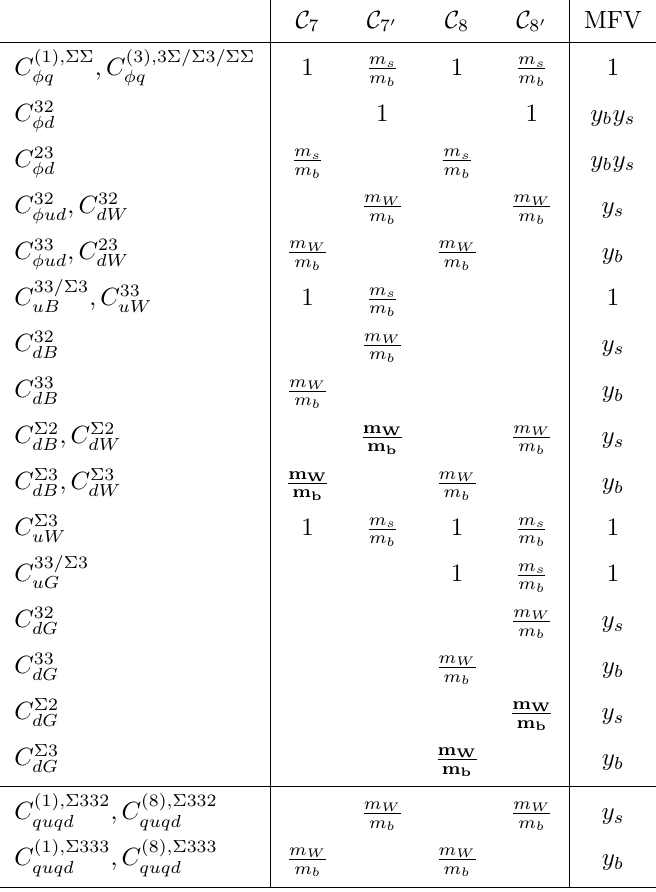
Table 10 . Scaling of SMEFT coefficients with the external quark masses in SMEFT-to-WET matching at one-loop level, relative to the SM contribution. Tree-level contributions with chiral enhancement are written in boldface. Sub-dominant contributions in the quark masses have been neglected. In matching contributions with left-handed quarks the sum over flavor indices k ∈ { 1 , 2 , 3 } is denoted as P . Contributions to C 9 , C 9 0 , C 10 and C 10 0 do not feature a chiral enhancement. In the last column we show the scaling of the flavor structure of SMEFT coefficients with the Yukawa couplings in